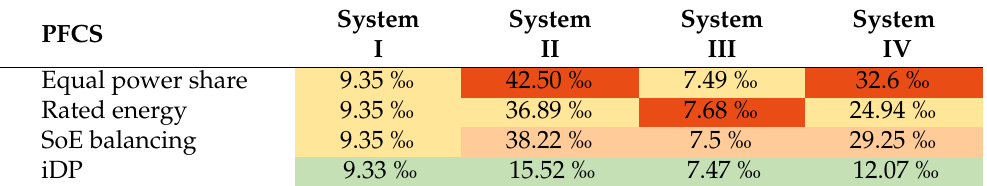
Table 3. Cumulative loss of energy of different power split methods for load profile I. Energy losses are given relative to the total energy of the system.